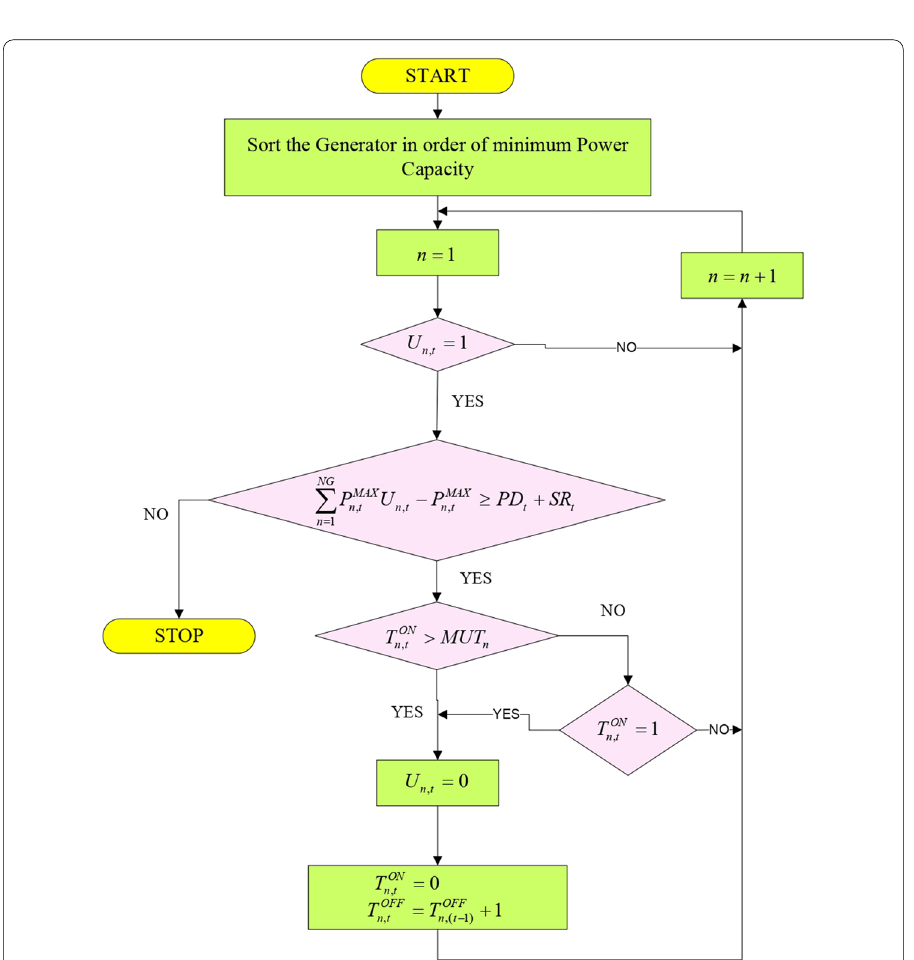
Fig. 10 Flowchart for the decommitment for excessive power generating